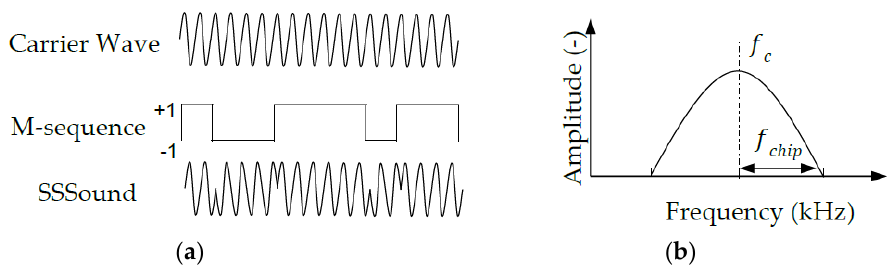
Figure 1. Generation ( a ) and frequency range ( b ) of Spread Spectrum Sound (SSSound).